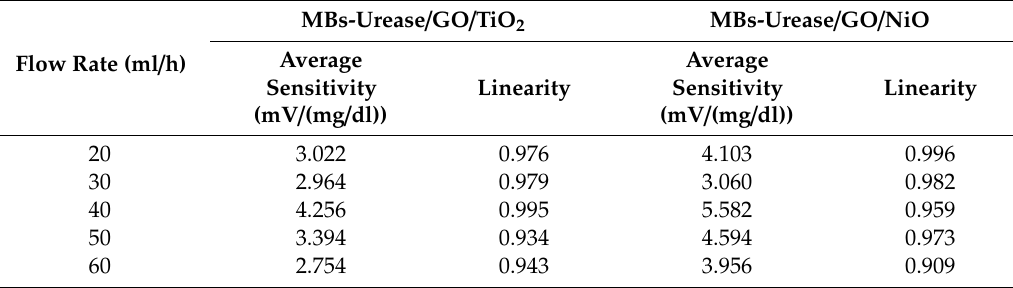
Figure 7. The responses of the urea biosensor based on MBs-urease / GO / TiO 2 by integrating the microfluidic measurement system. Table 2. The sensing properties of the di ff erent urea biosensors at di ff erent flow rates by integrating the microfluidic measurement system.